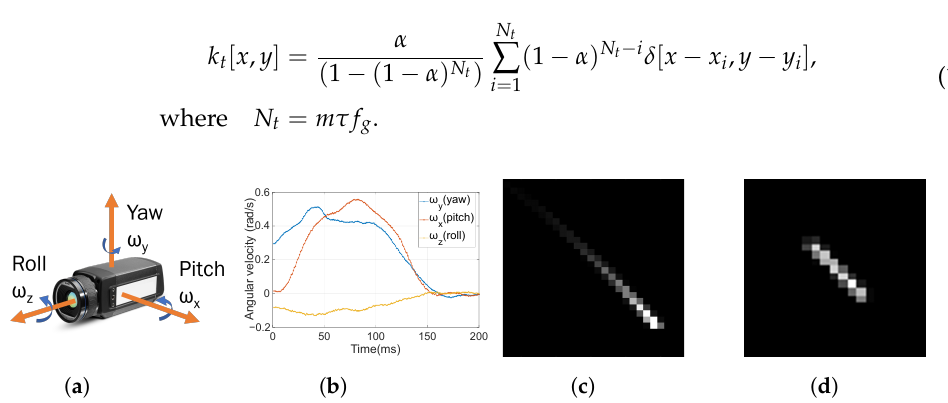
Figure 7. Illustration of camera rotation. ( a ) 3-axis rotation model, ( b ) Rotation motion measured by gyroscope sensor, ( c ) Blur kernel rendering result using the thermal detector model, ( d ) Blur kernel rendering result using the photon detector